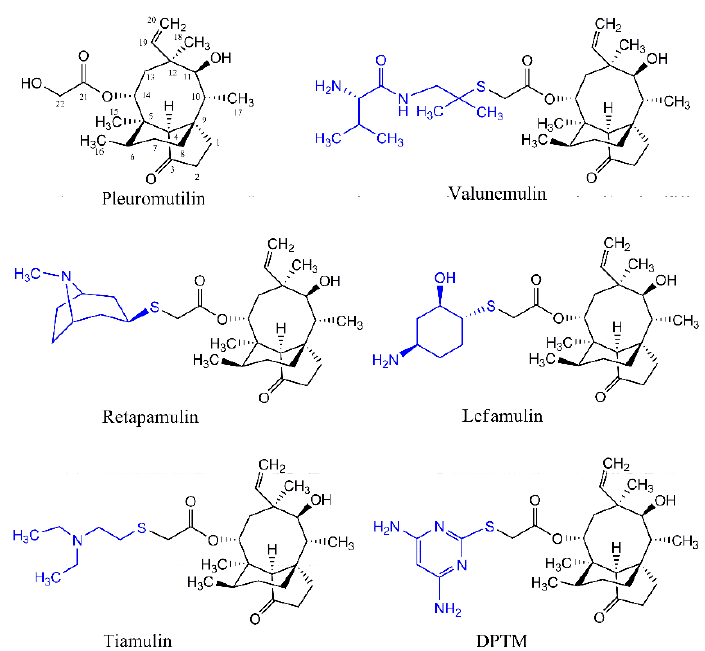
Figure 1. Chemical structures of pleuromutilin tiamulin, valnemulin, retapamulin, Lefamulin, and DPTM.